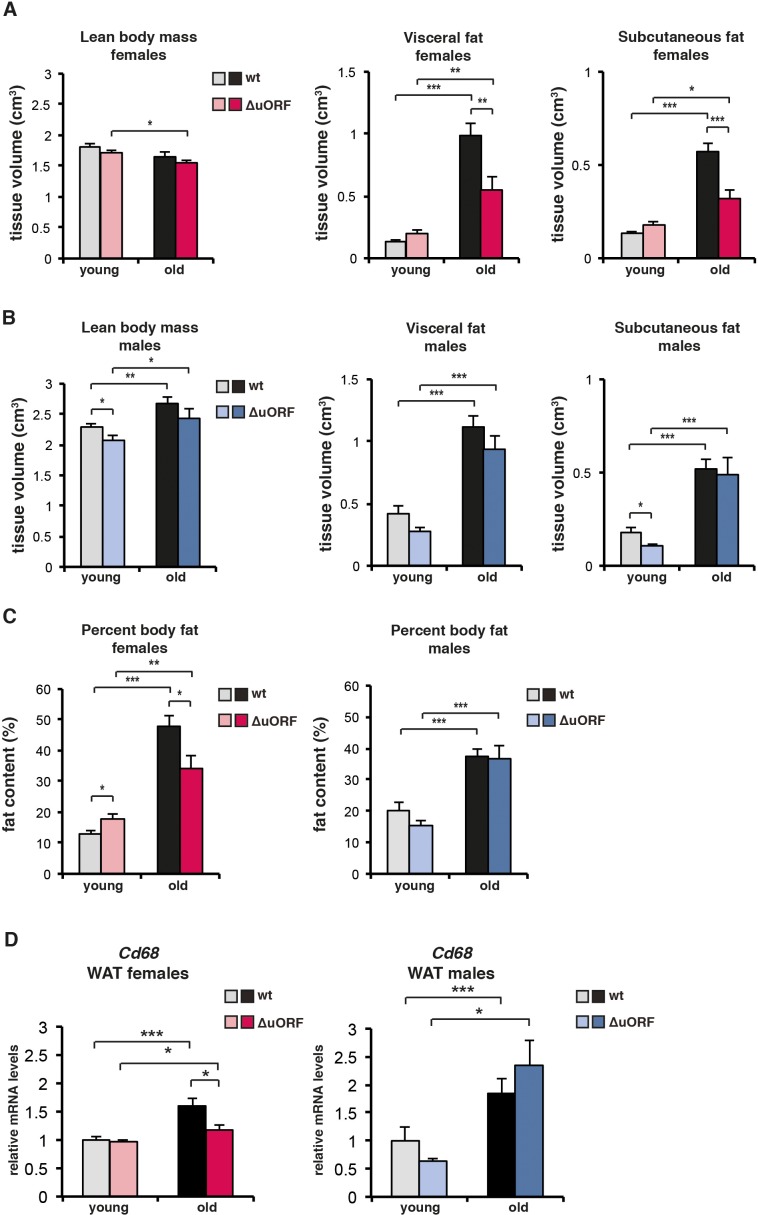
Analysis of lean body mass, fat volume, and expression of theCd68macrophage marker in young and old mice.(A-C) Body composition of young (4 months) and old (females 19 months, males 21 months) wt and C/EBPβΔuORF mice was determined by computer tomography (CT) analysis. (A) The bar graphs show tissue volumes (cm3) of lean body mass, visceral fat and subcutaneous fat for females, and (B) for males. (C) Percentage of body fat for females (left) or males (right). (wt females, n=11 young and old; wt males, n=12 young and old; C/EBPβΔuORF females, n=9 young, n=11 old; C/EBPβΔuORF males, n=11 young, n=9 old). (D) RelativeCd68-mRNA levels as determined by quantitative real-time PCR in visceral fat of young (5 months) and old (females 20 months, males 22 months) wt and C/EBPβΔuORF females (left) and males (right) as a measure for macrophage infiltration (wt females, n=11 young and old; wt males, n=11 young, n=12 old; C/EBPβΔuORF females, n=11 young and old; C/EBPβΔuORF males, n=11 young, n=10 old). P-values were determined by Student’s t-test, *p<0.05; **p<0.01; ***p<0.001.